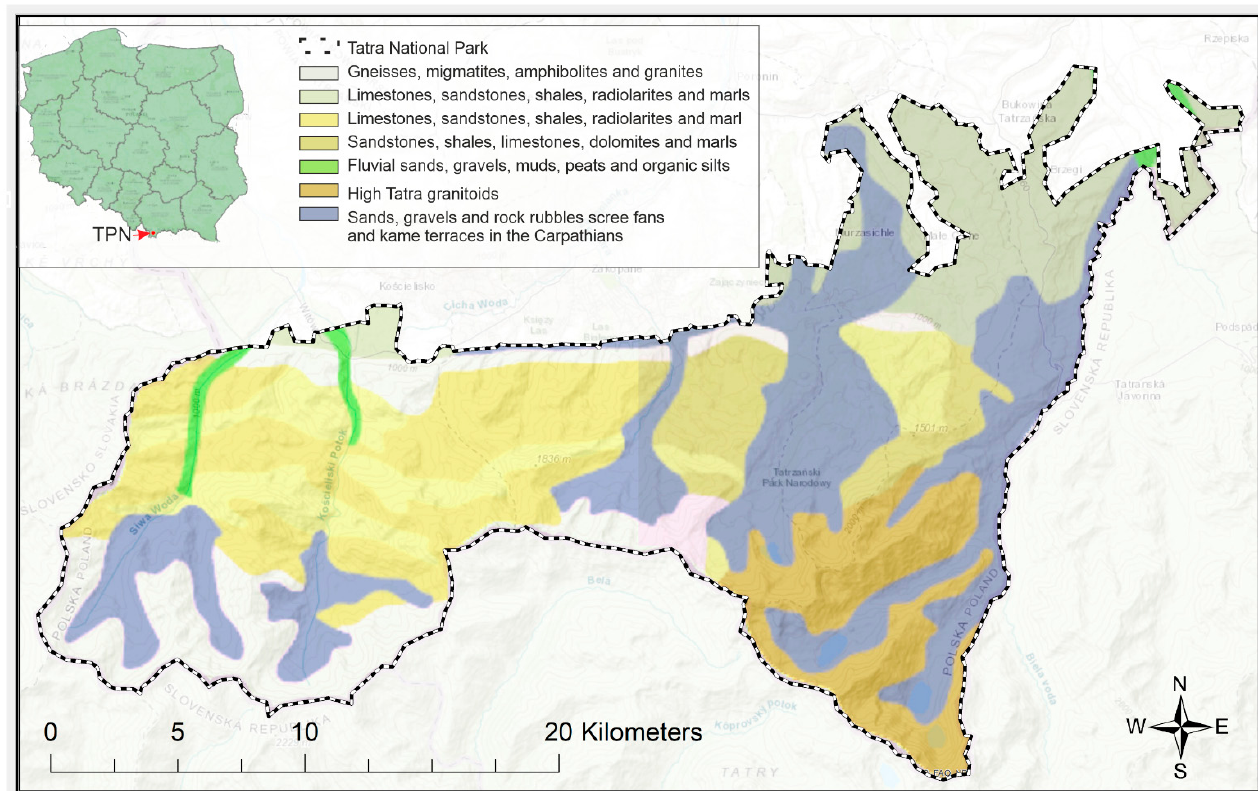
Figure 1. The geological formations in the polish part of the Tatra Mountains based on Polish Geological Institute data [29] .